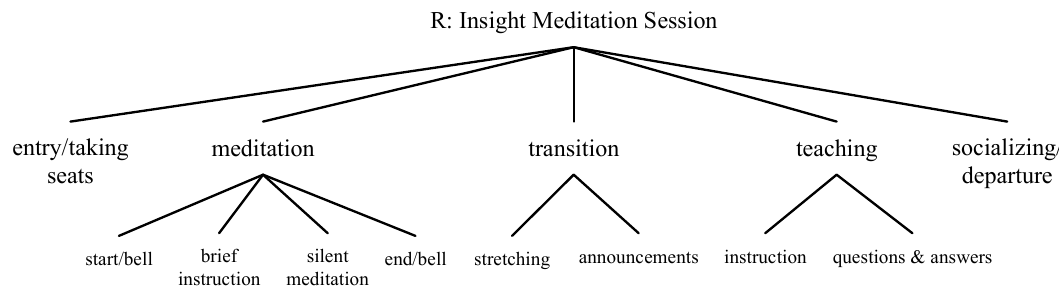
Figure 3. Syntax of Insight Meditation Session.